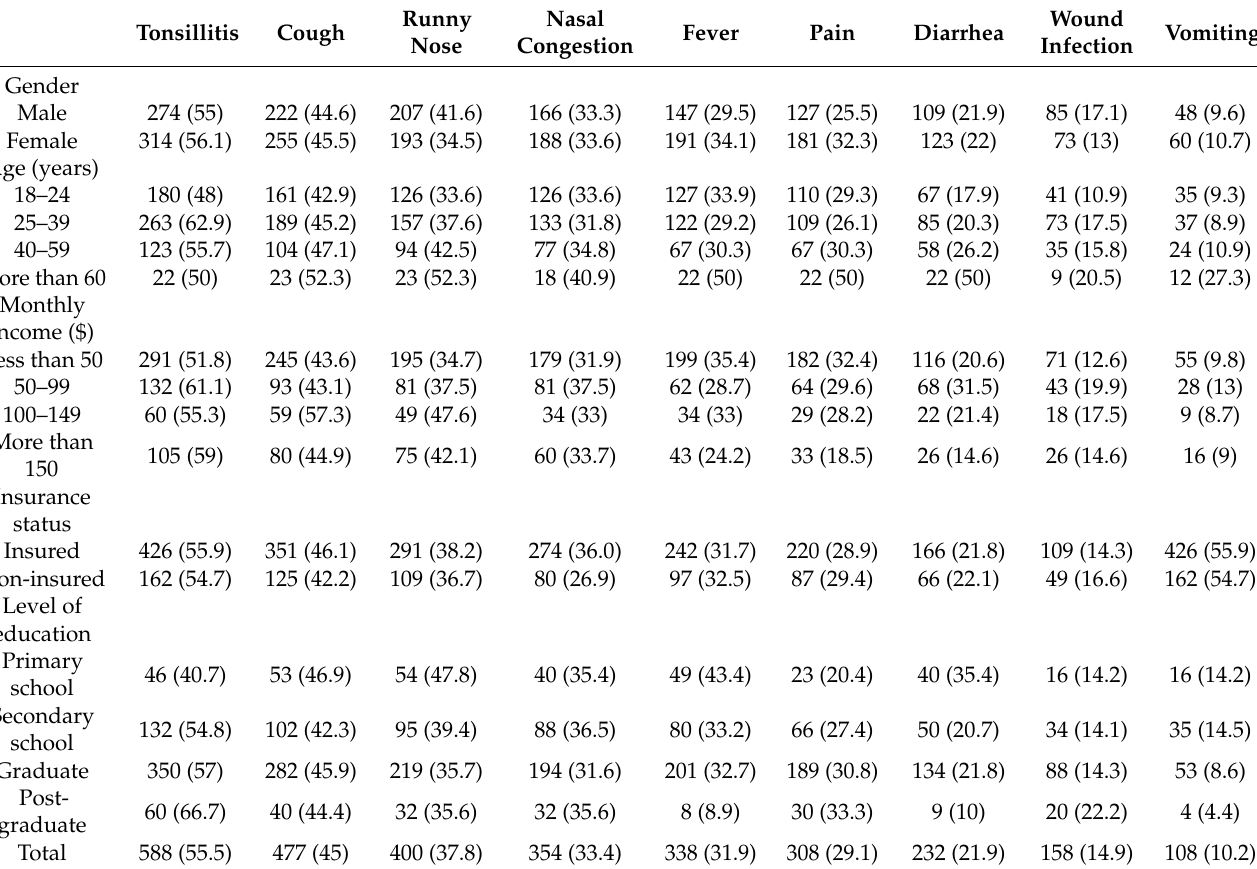
Table 3. Relation between common ailments of SMA and demographic characteristic of the included